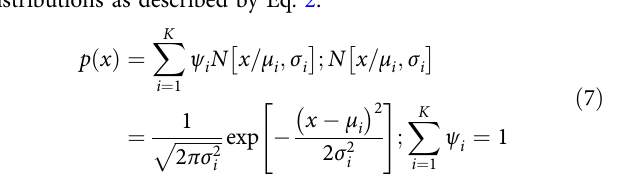
¼ L ¼ 1 μ m ; N P